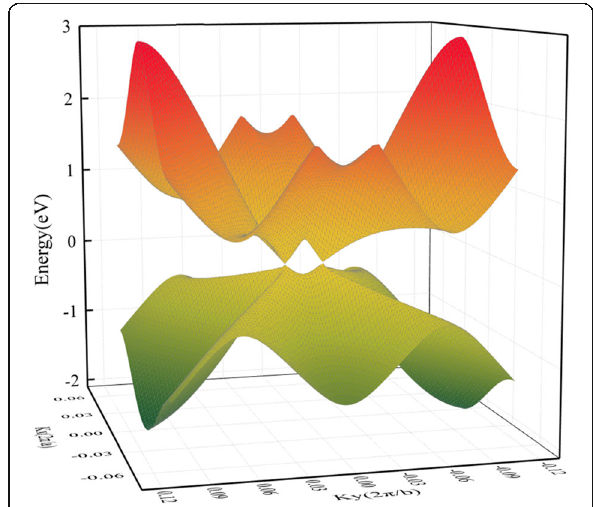
Fig. 1c. The crossing point of energy bands at the Fermi level indicates semimetallicity of HOT graphene, which is confirmed by the vanishing DOS at the Fermi